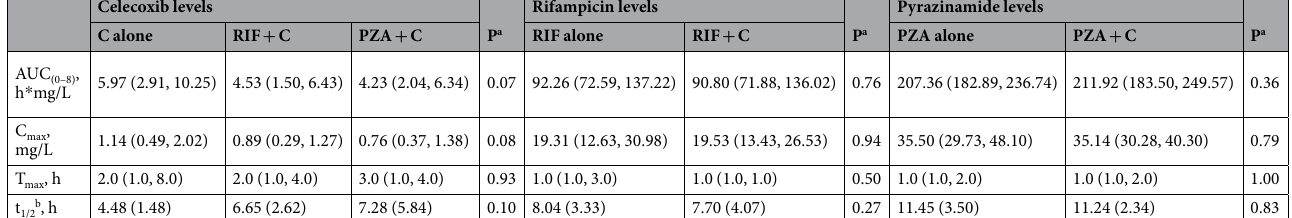
Table 1. Summary of Pharmacokinetic (PK) Characteristics. Values are geometric mean and range (min, max) for AUC (0–8) and C max ; median (min, max) for T max ; mean (SD) for t 1/2 . a P values for comparison of PK parameters AUC (0–8) (log-transformed), C max (log-transformed) and t 1/2 between groups by repeated-measure ANOVA (celecoxib levels) or paired-sample t-test (rifampicin levels and pyrazinamide levels), and T max by Friedman’s test (celecoxib levels) or Wilcoxon signed rank test (rifampicin levels and pyrazinamide levels). b t 1/2 estimation includes 24 hour data where available (6 in PZA group, 2 in RIF group). Abbreviations: C, celecoxib; RIF, rifampicin; PZA,